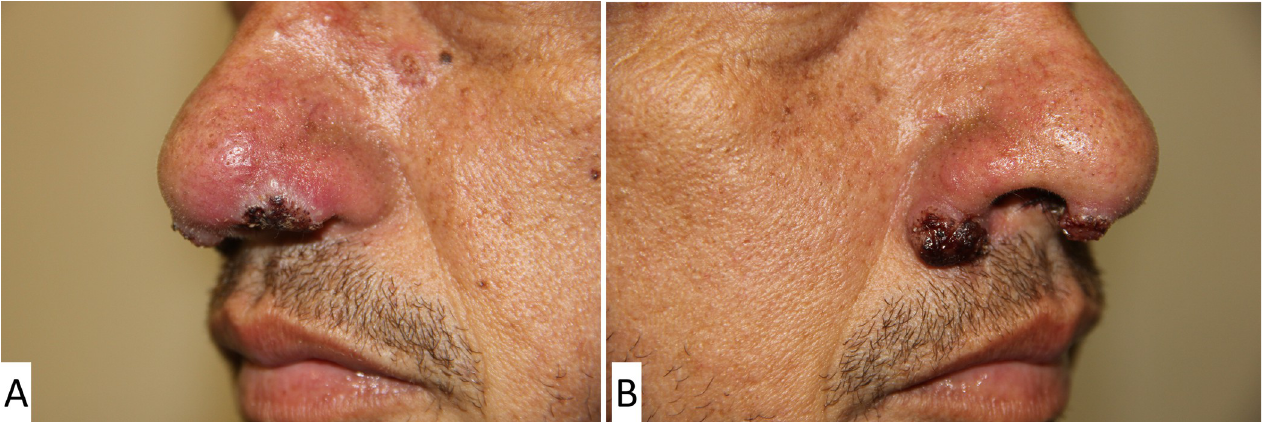
Fig 1. Ulcerated lesions on the nasal skin and